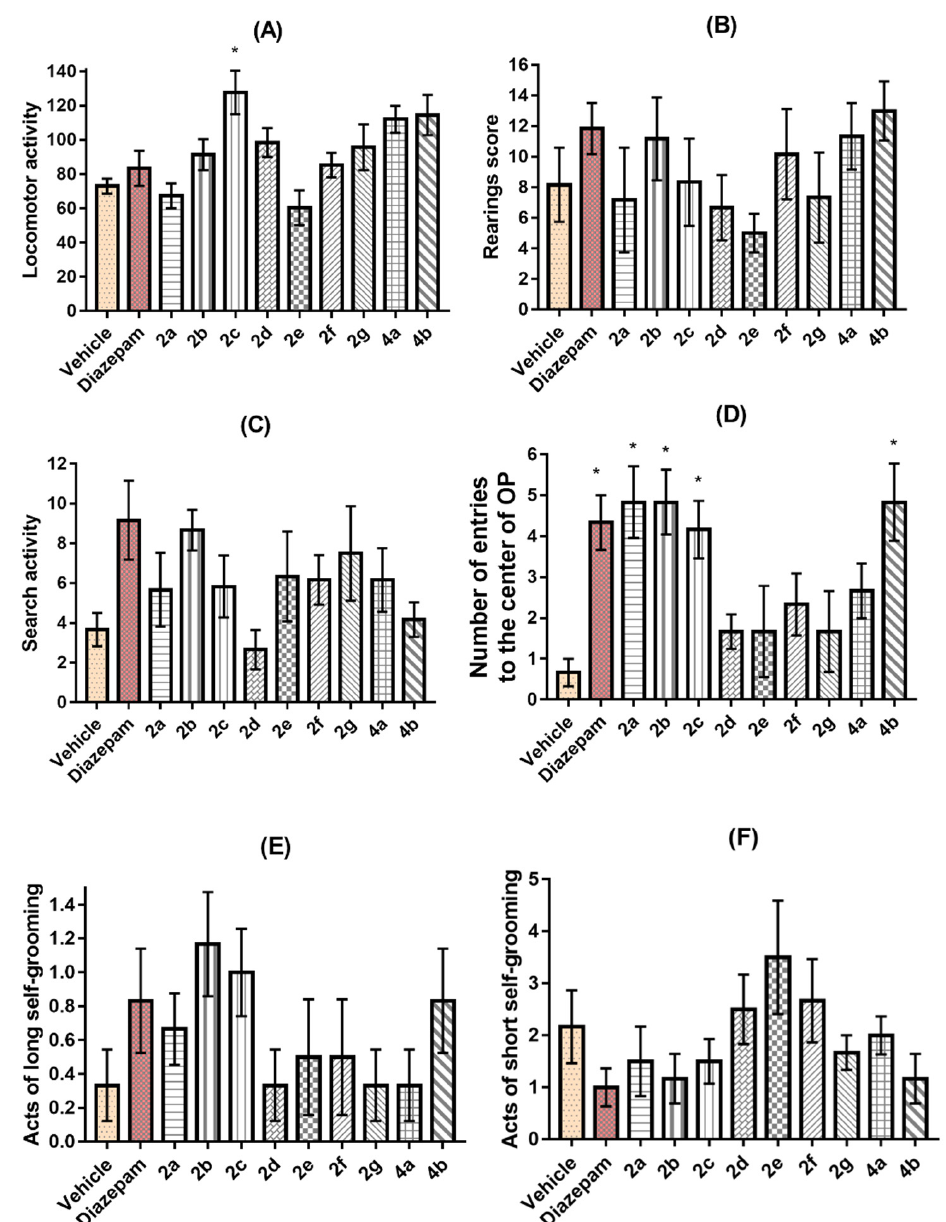
Figure 2. Behavioral activity of compounds in Open Field test in comparison with diazepam (1 mg/kg), mice, per oral administration, M ± SEM. Note: * Data are comparable to the control group ( p < 0.05, Kruskal-Wallis test post-hoc Dunn’s test): ( A ) locomotor activity; ( B ) rearings score; ( C ) search activity; ( D ) number of entries to the center of Open field; ( E ) number of long self-grooming acts; ( F ) number of short self-grooming